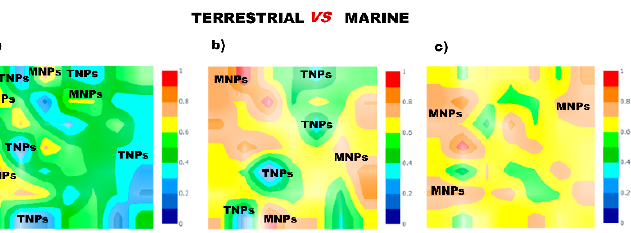
Figure 1. Generative Topographic Mapping (GTM) terrestrial and marine origin of NPs landscape for: ( a ) the test set; ( b ) the StreptomeDB 2.0 database; and ( c ) the Pye data set.